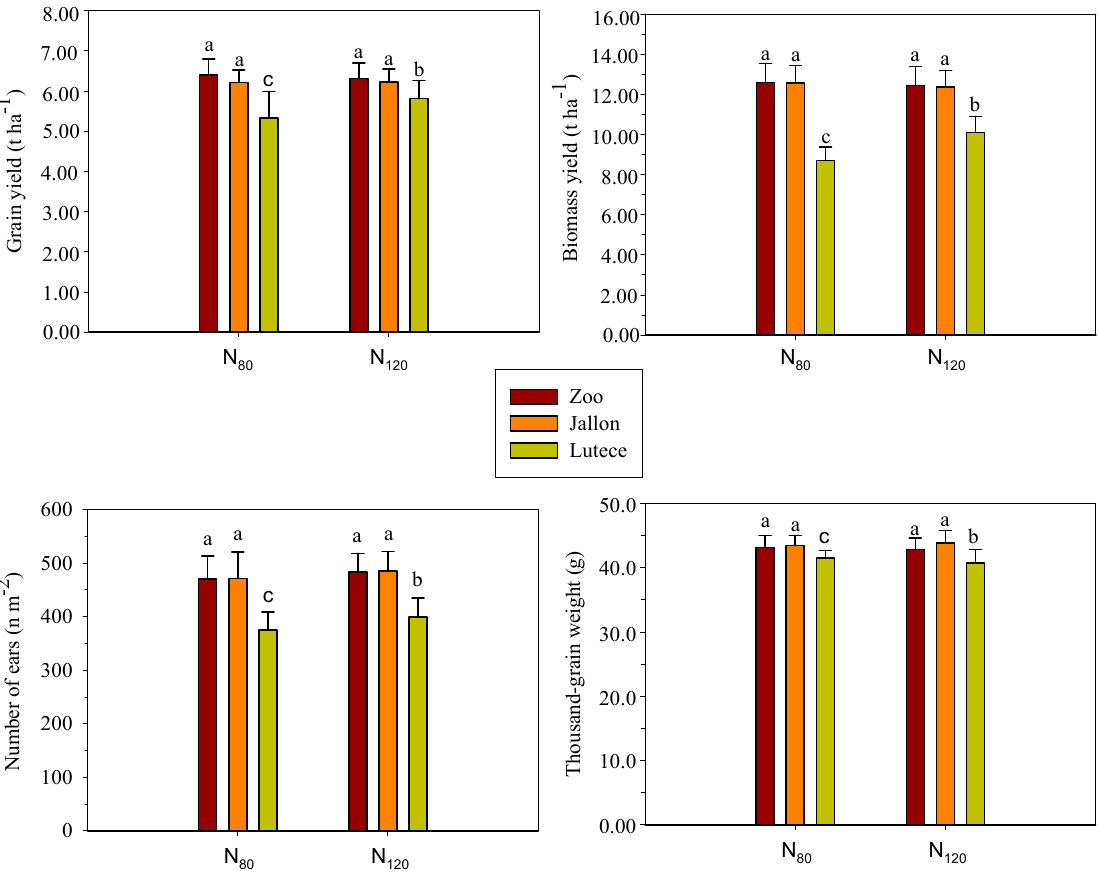
Figure 4. Grain yield, biomass yield, number of ears, and 1000-kernel weight depending on nitrogen dose (N) and variety (mean ± SD, n = 18). Within each graph, bars marked with different letters are statistically different ( p ≤ 0.05) according to Tukey’s HSD Test.